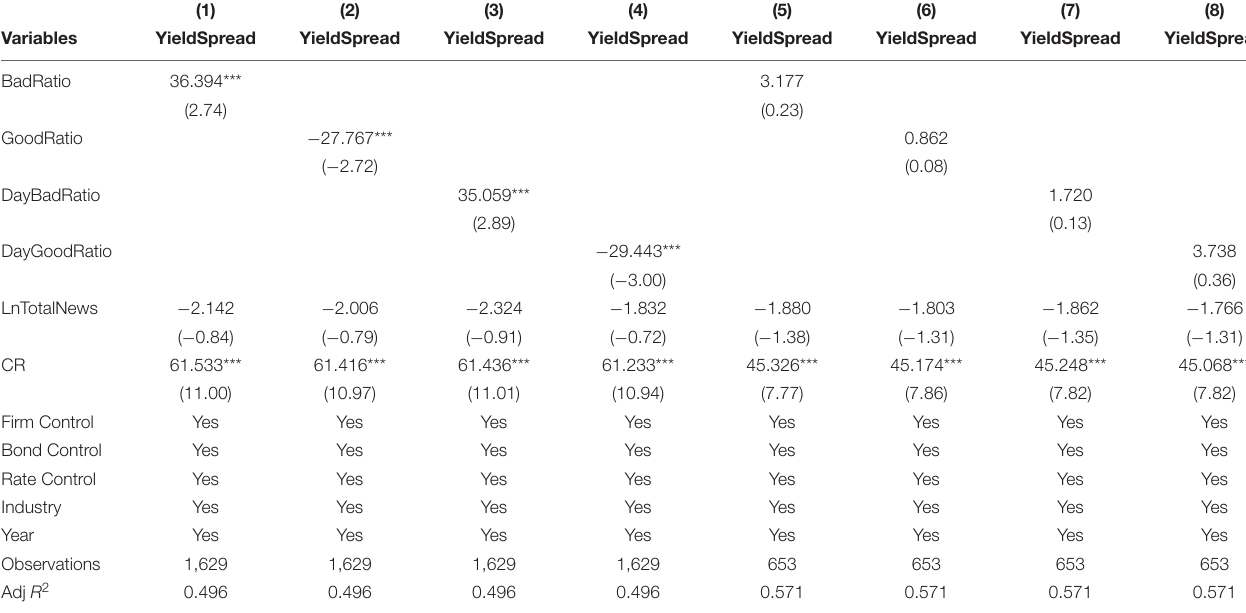
TABLE 8 | Robust check